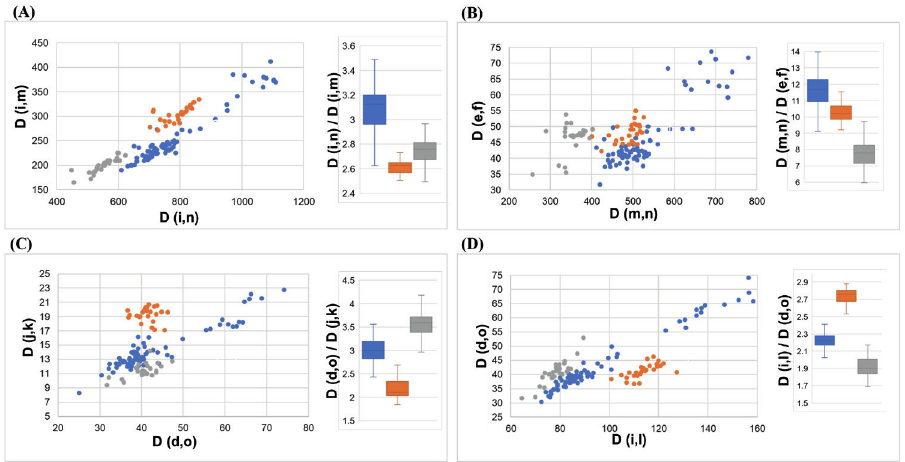
Figure 5. The simple regression and the boxplot analysis in T. japonicus (blue), T. lepturus (orange) and T. nanhaiensis (grey) A Total length [D(i,n)] and Preanal length [D(i,m)] B Caudal length [D(m,n)] and Body depth at anus [D(e,f)] C Head depth [D(d,o)] and Orbital length [D(j,k)] and D Head length [D(i,l)] and Head depth [D(d,o)]. The landmarks are illustrated in Fig.